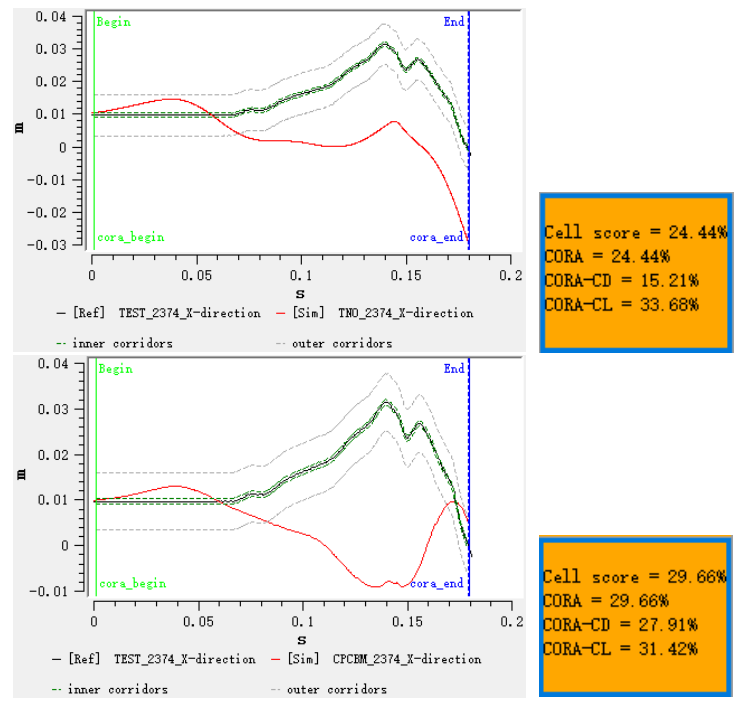
Figure A11. X-direction displacement signals between experiment and simulation.